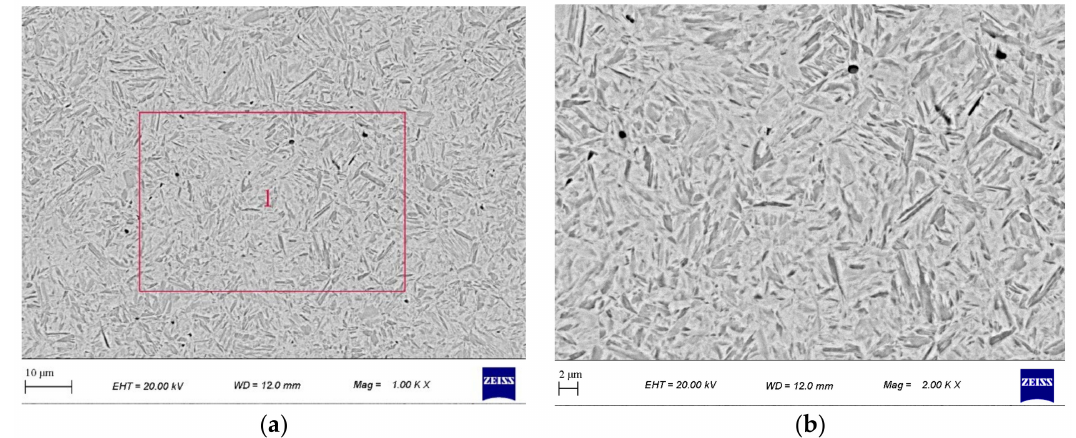
Figure 7. Morphology of hardened layer; ( a ) 1000 magnification and ( b ) area 1 at 2000 × magnification.